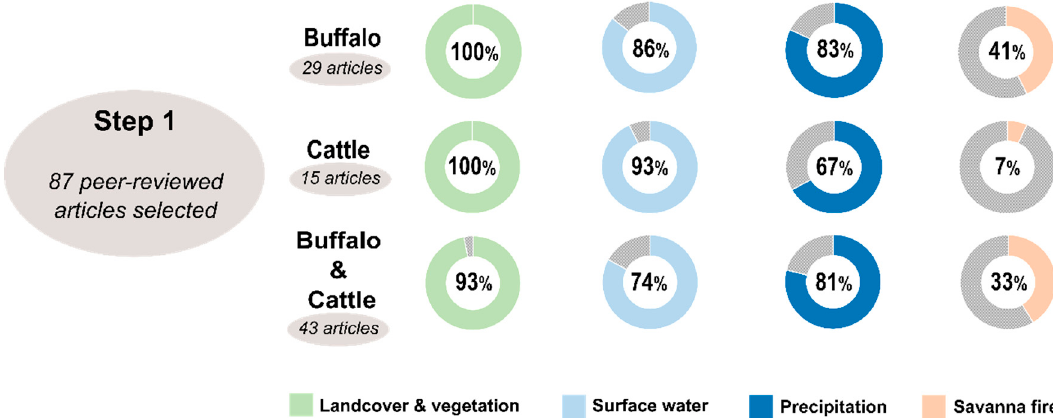
Figure 1. Environmental driver statistics of the step 1 bibliography. The percentage of articles identifying the environmental drivers of animal movements among all the peer-reviewed selected articles is presented according to the species considered (buffalo only, cattle only, buffalo & cattle).